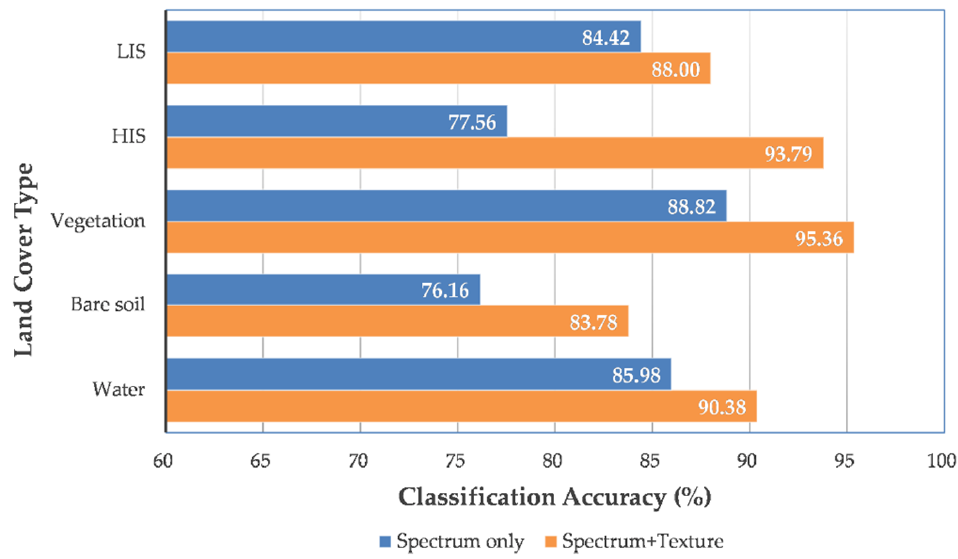
Figure 3. Comparison of classification accuracy between different classification strategies (blue: classification based on spectrum only; orange: classification based on spectrum and texture).